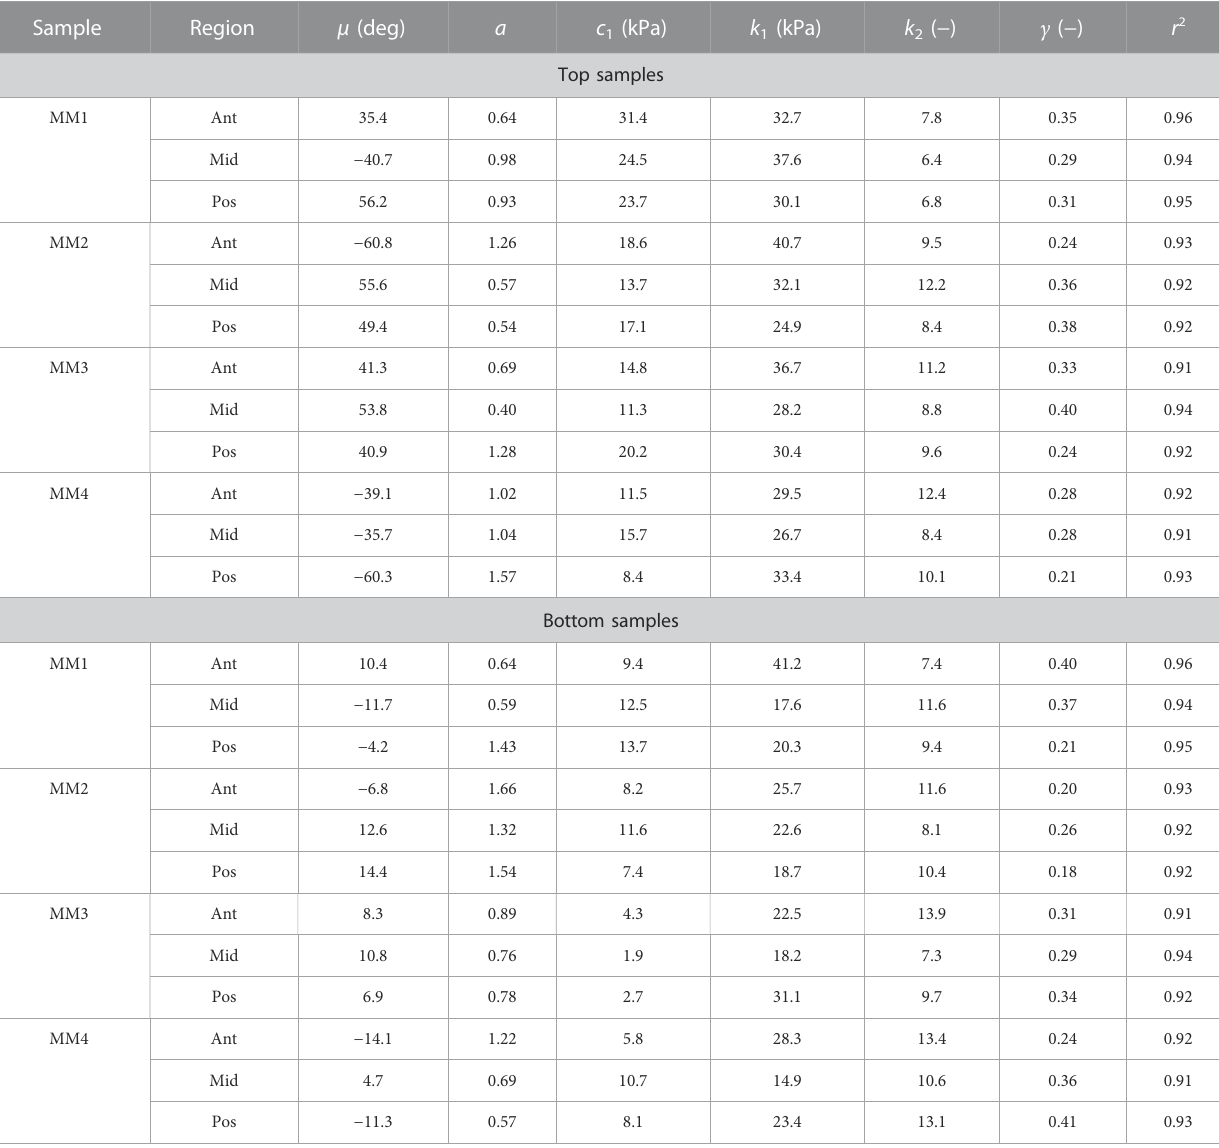
TABLE 2 Collagen morphology and tissue material parameters for top and bottom samples from medial menisci. MM denotes medial meniscus.